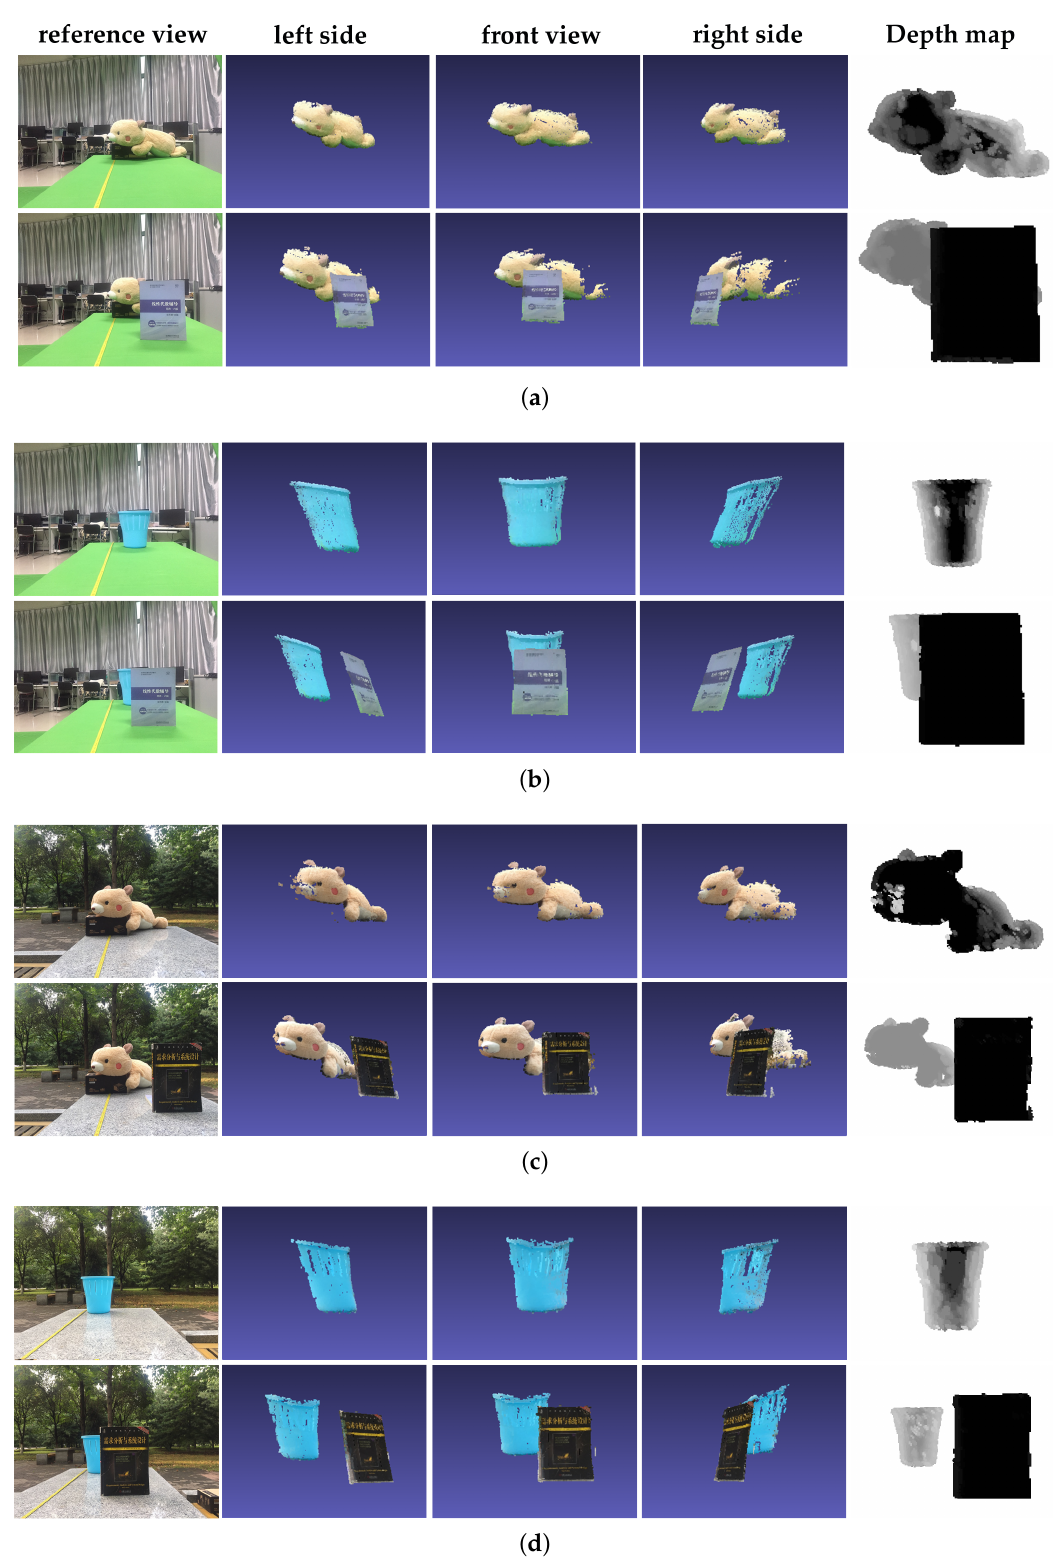
Figure A5. ( a ) Reconstructed toy bear in indoor scene. ( b ) Reconstructed trash bin in indoor scene. ( c ) Reconstructed toy bear in outdoor scene. ( d ) Reconstructed trash bin in outdoor